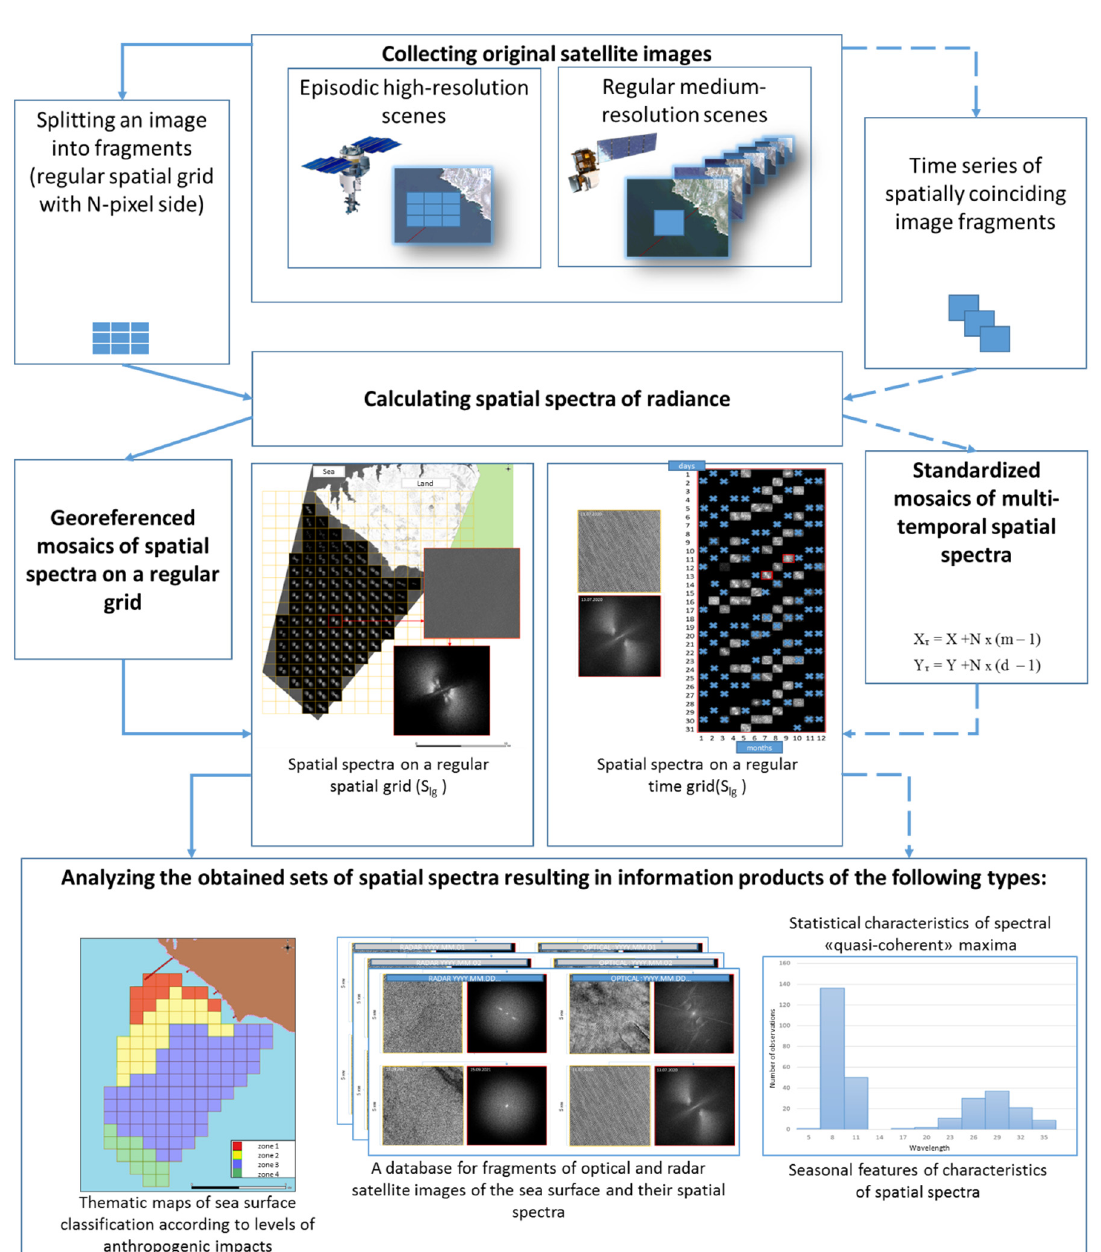
Figure 2. A flowchart of research methodology based on the analysis of spatial spectra of high- and medium-resolution optical and radar satellite imagery to study anthropogenic impacts on coastal water areas.